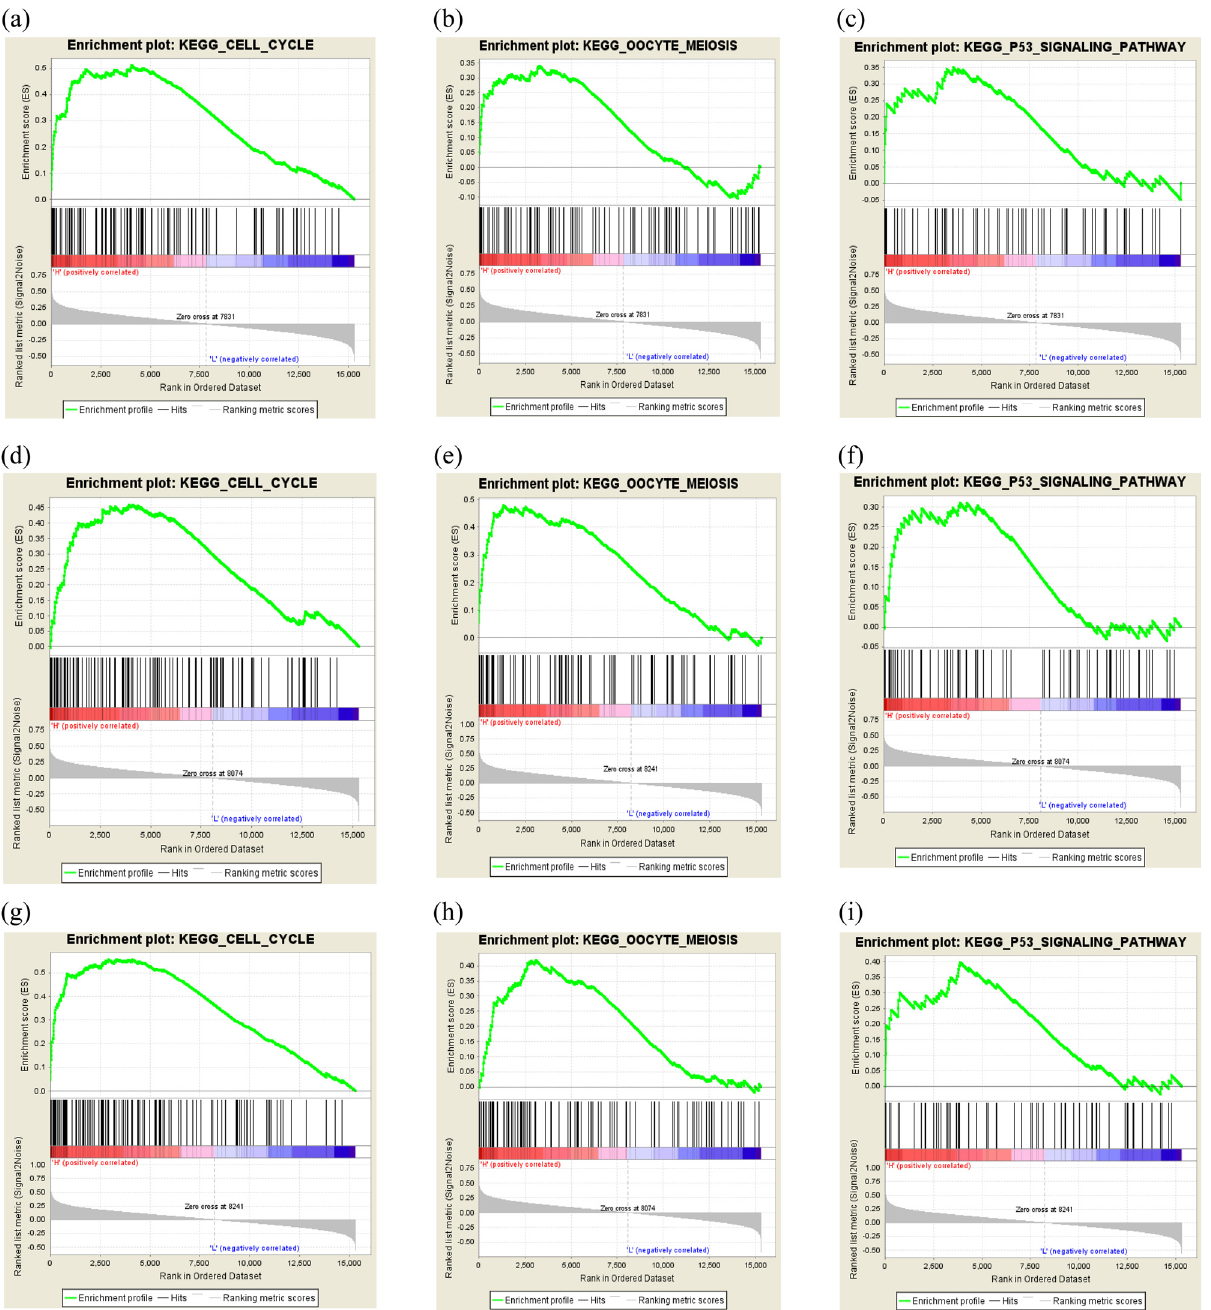
Figure 5: GSEA analysis of CDC20 ( a – c ) , CCNB2 ( d – f ) and BUB1 ( g – i )